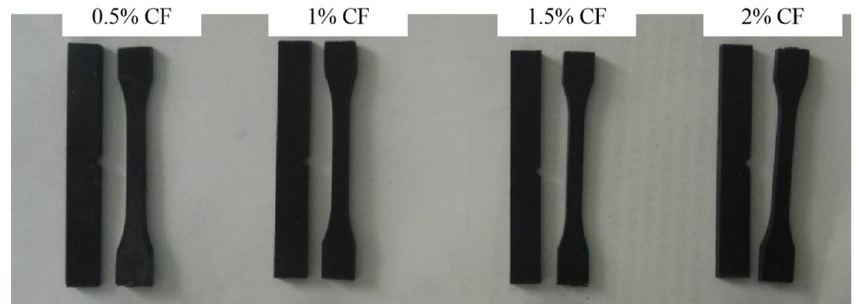
Figure 2. Test sample of carbon fiber (CF) modified PTFE composite.